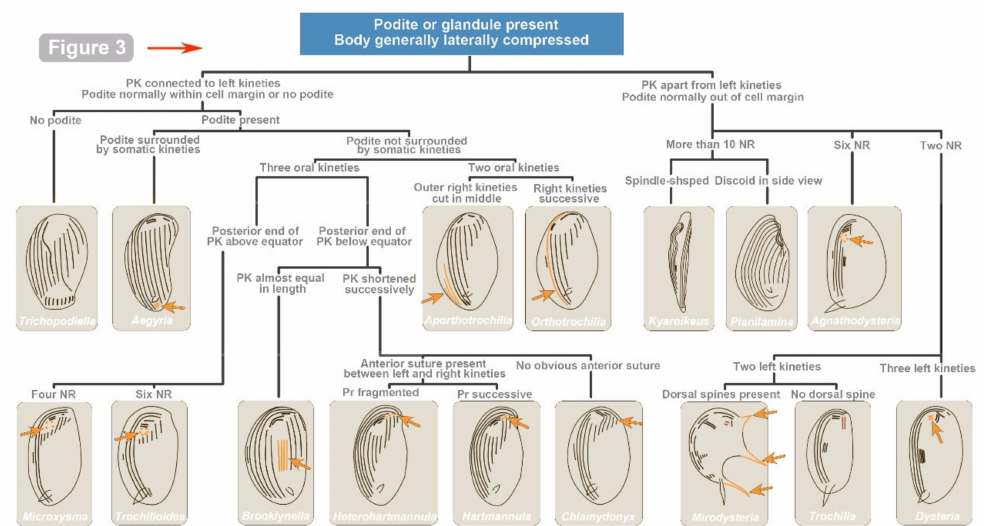
Figure 4. Illustrated key for the identification to cyrtophorian genera found in China (Figure 3 contin- ued). All the illustrations are original. The arrows and colored structures indicate dichotomic charac- teristics. Abbreviations: NR—nematodesmal rods; PK—postoral kineties; and Pr—preoral